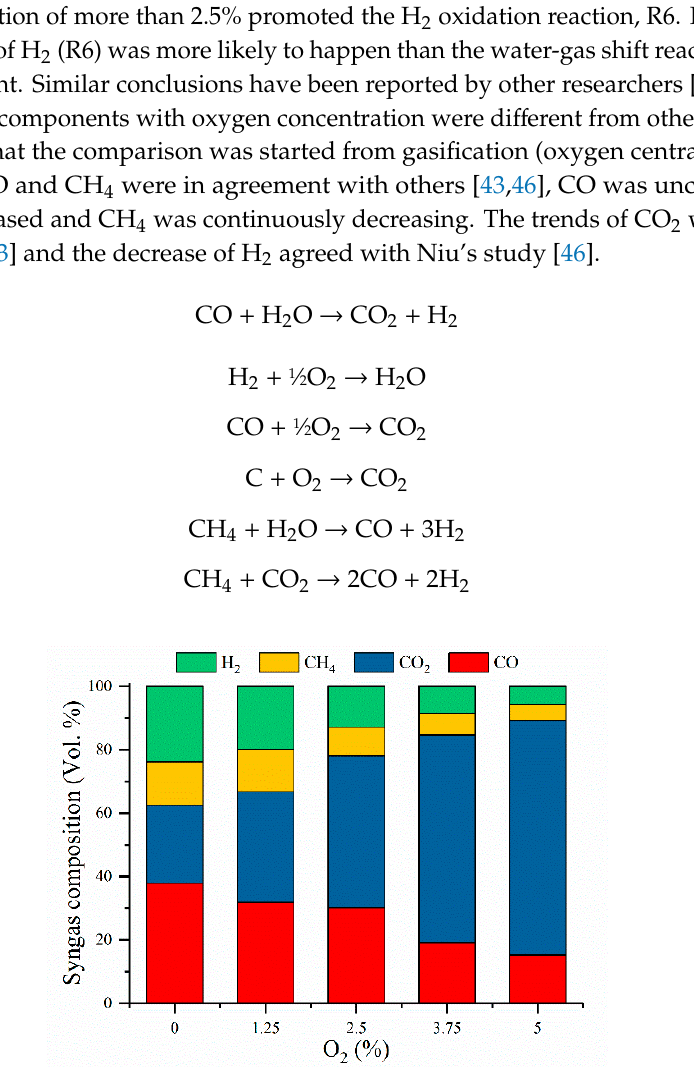
Figure 4. Effect of oxygen concentration on gas composition at 650 °C during gasification. Figure 4. E ff ect of oxygen concentration on gas composition at 650